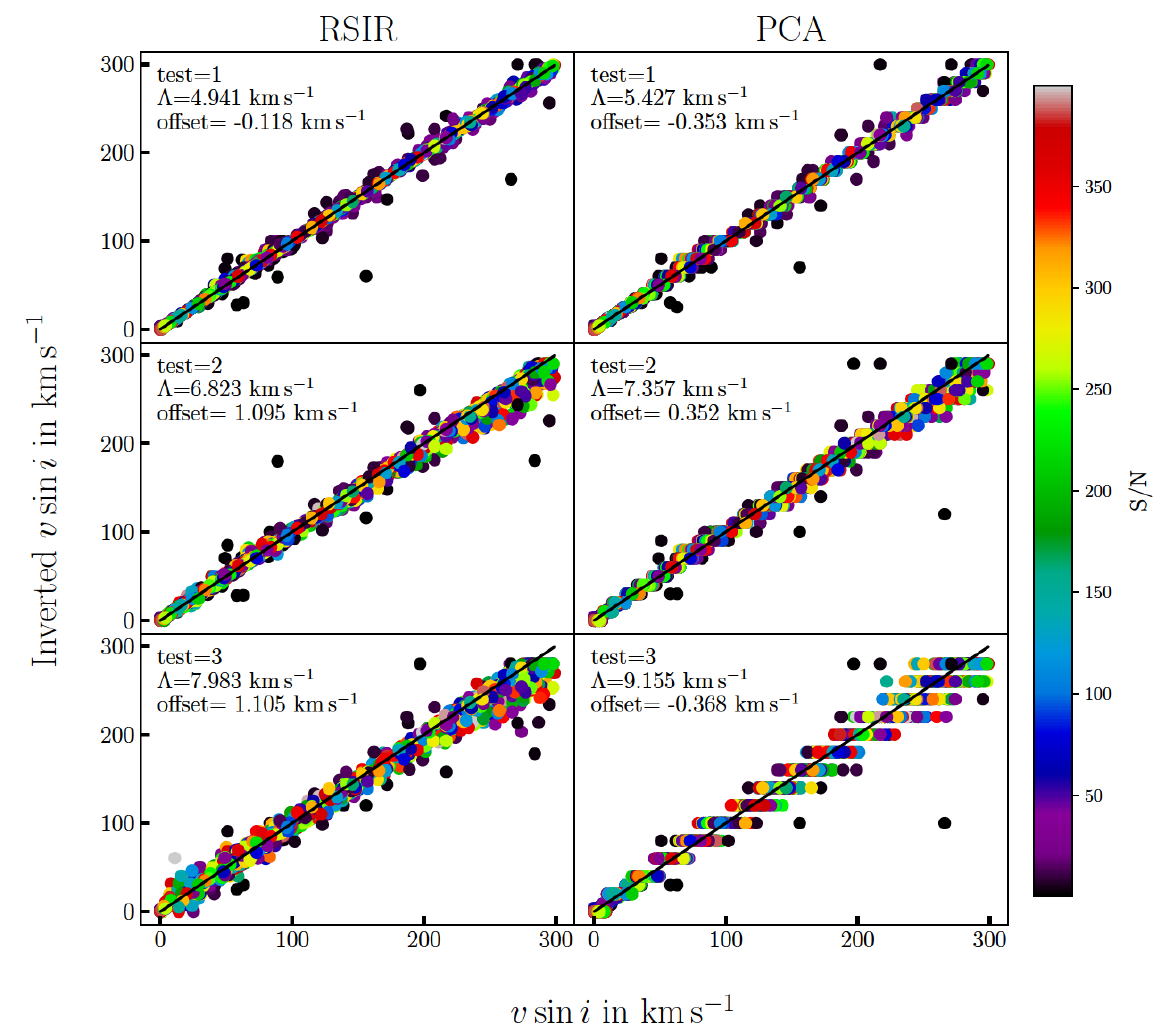
Figure A3. Results of projected equatorial velocity inversion for the synthetic A to K